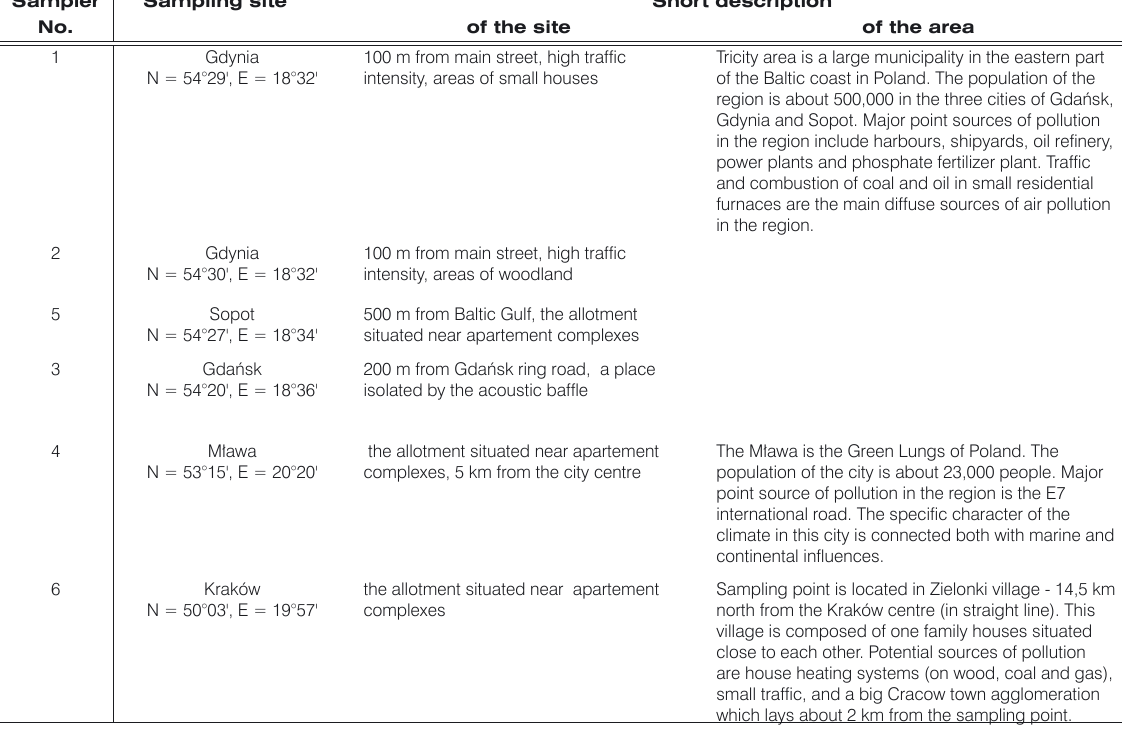
Table 1. Description of the sampling sites